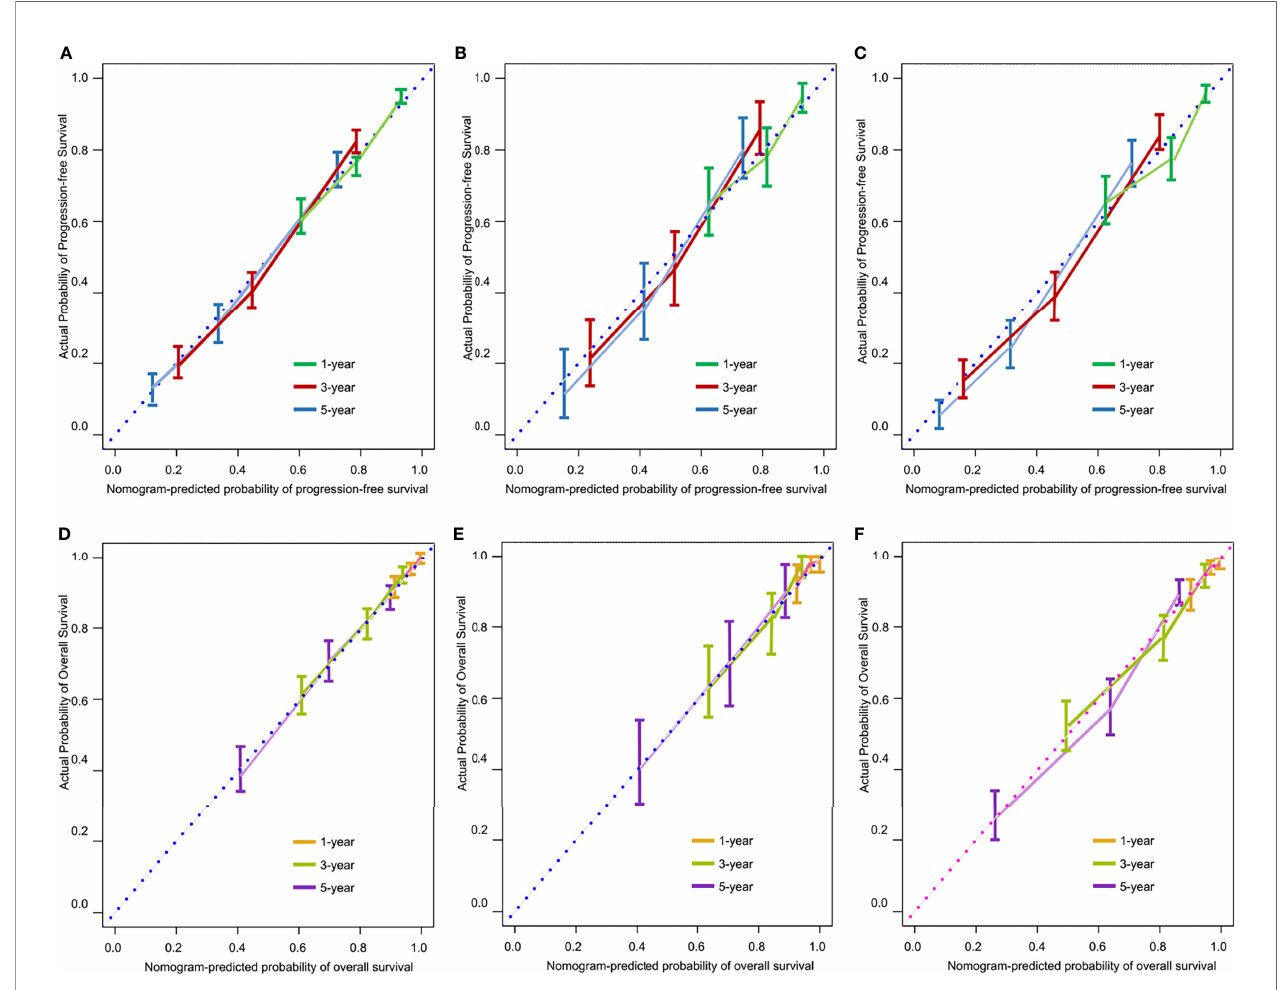
FIGURE 4 | Calibration curves for predicting 1-, 3-, and 5-year progression-free survival (PFS) in the training (A) , internal validation (B) , and external validation (C) cohorts, and for predicting 1-, 3-, and 5-year overall survival (OS) in the training (D) , internal validation (E) , and external validation (F) cohorts.